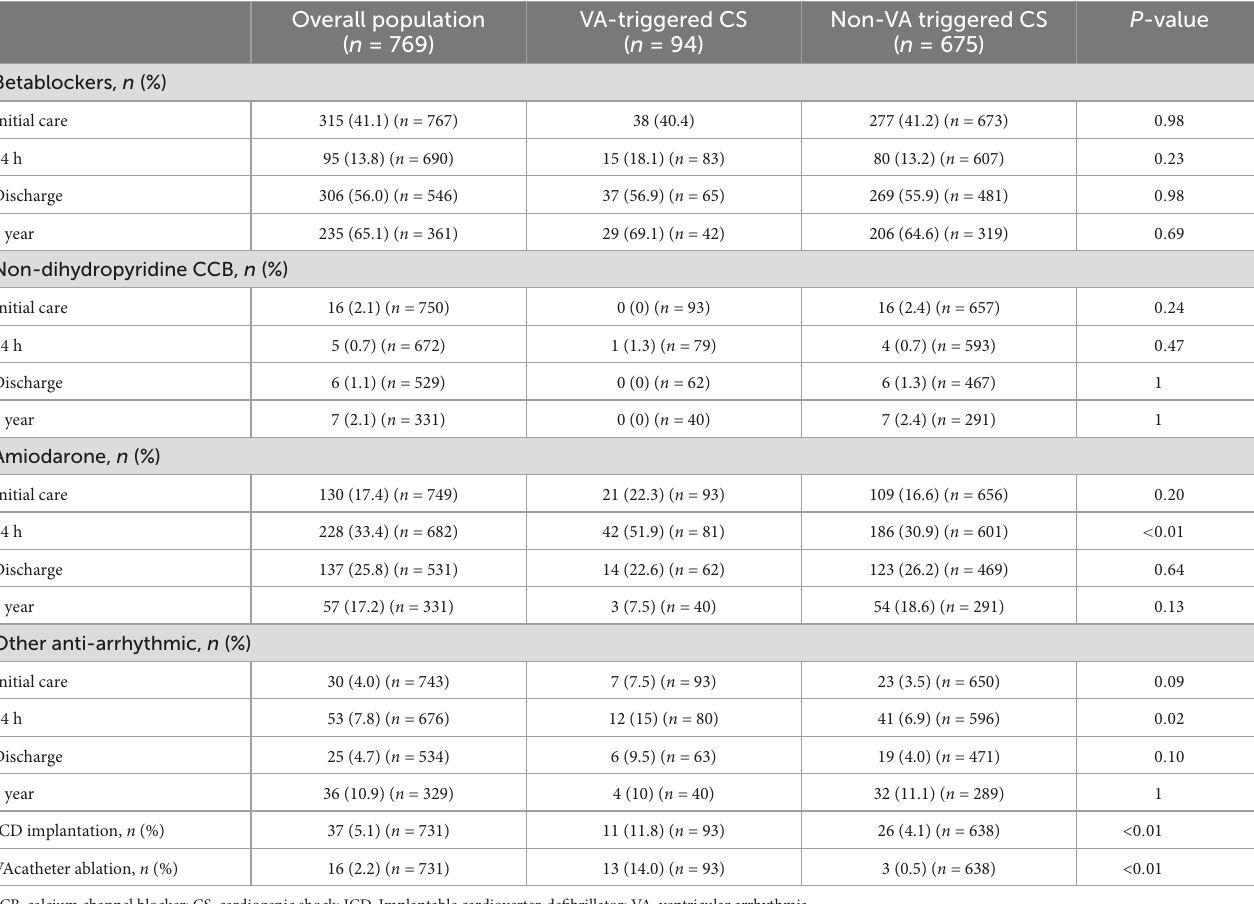
Overall population ( n = 769)